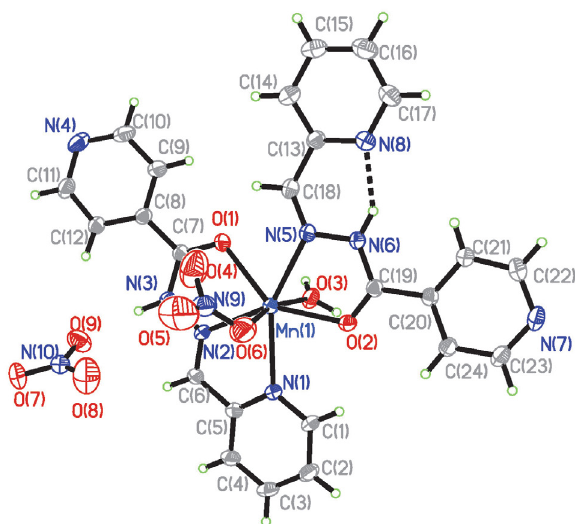
Figure 3. ORTEP diagram of complex 2 (30% thermal ellipsoid).